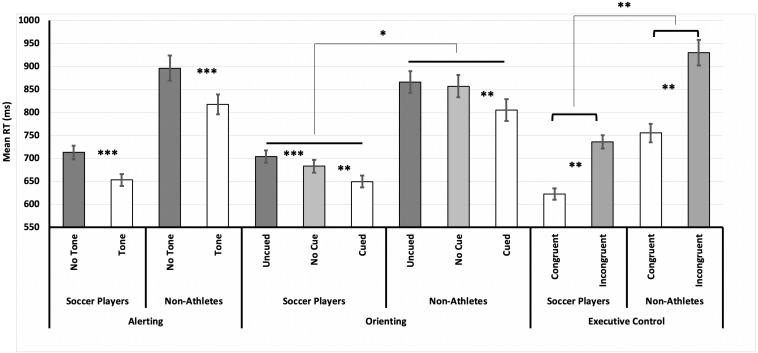
Mean reaction time (RT) for each experimental condition used to measure each attentional function, as a function of Deliberate Sport Practice. For alerting, only no-cue trials were used to compute the means. Note that soccer players were faster in general than non-athletes and showed reduced interference (i.e., reduced difference between congruent and incongruent conditions). Error bars represent the standard error of the mean. *Indicates significant differences between groups and attentional conditions (*p < 0.05, **p < 0.001, ***p < 0.0001).